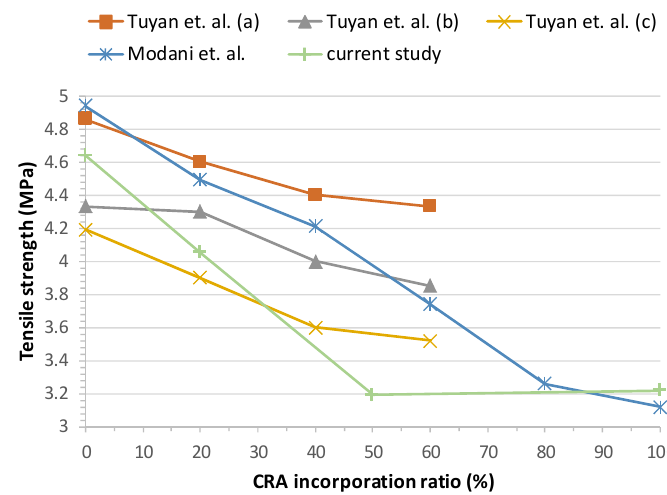
Figure 16. 28-day splitting tensile strength test results overview.